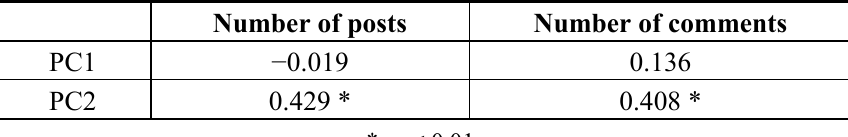
Table 4. Correlation coefficients between Principal Components (PC) scores and activity